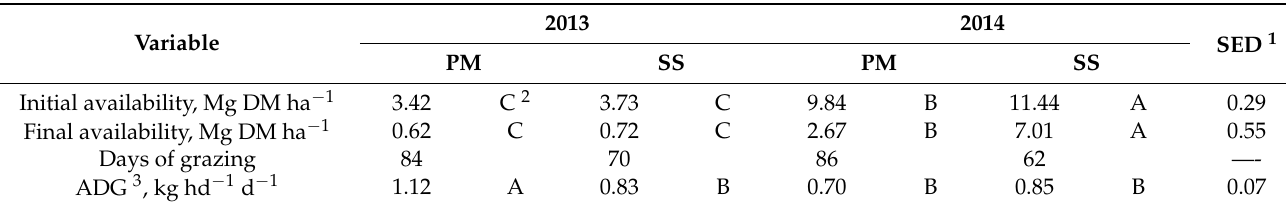
Table 4. The influence of year and forage species on pasture dry matter (DM) availability and animal weight gain of growing beef cattle grazing pearl millet (PM) and sorghum–sudangrass (SS) pastures during the frost-prone autumn at Tucumcari, NM USA, in 2013 and 2014. Data are the least squares means of two